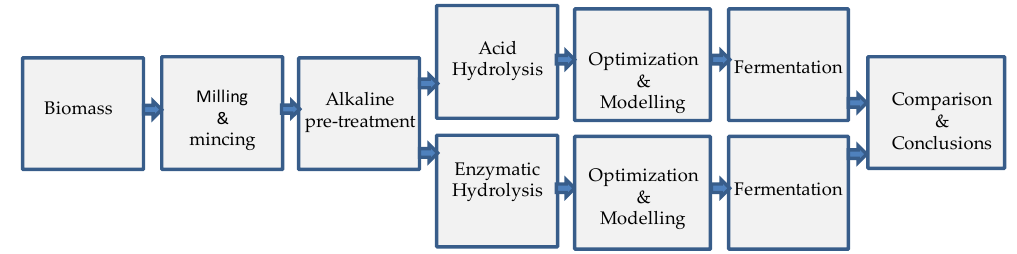
Figure 12. Steps of lignocelulosic biomass processing towards bioethanol. Table 10. Input variables for the Box-Behnken design.